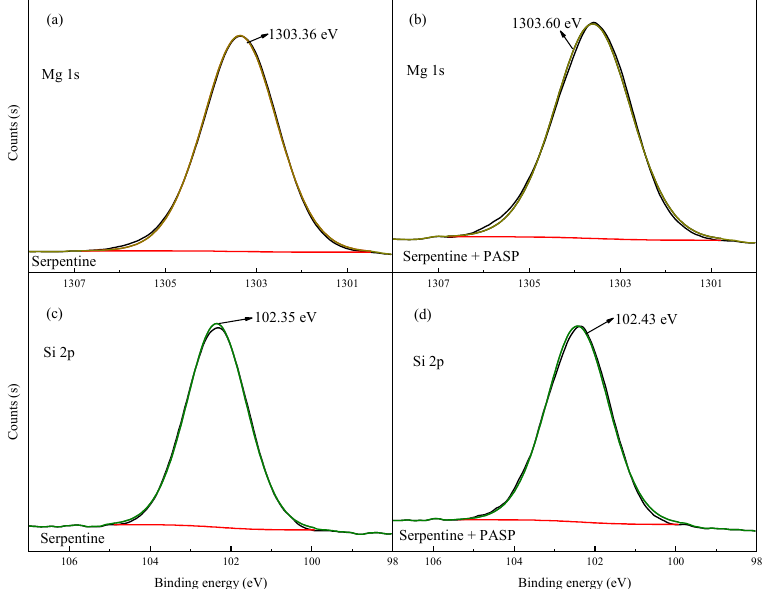
Figure 9. High-resolution spectra of ( a , b ) Mg 1s and ( c , d ) Si 2p of serpentine before and after the pretreatment of PASP (pH = 9). pretreatment of PASP (pH =